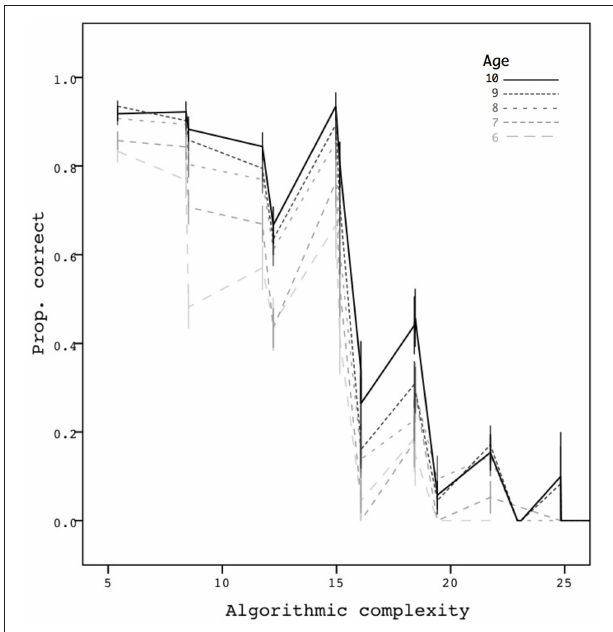
FIGURE 3 | Mean proportion correct as a function of complexity. Error bars are ± 1 standard errors. The mean proportion is based on 6580